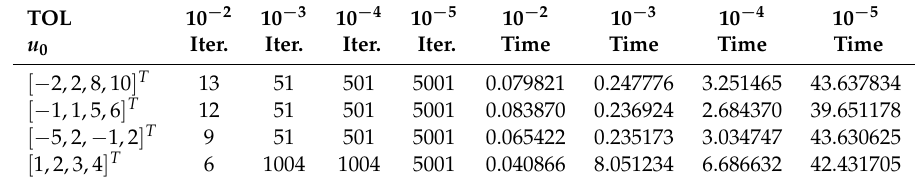
Table 1. Numerical behaviour of Algorithm 1 using different starting points for Example 1. TOL 10 − 2